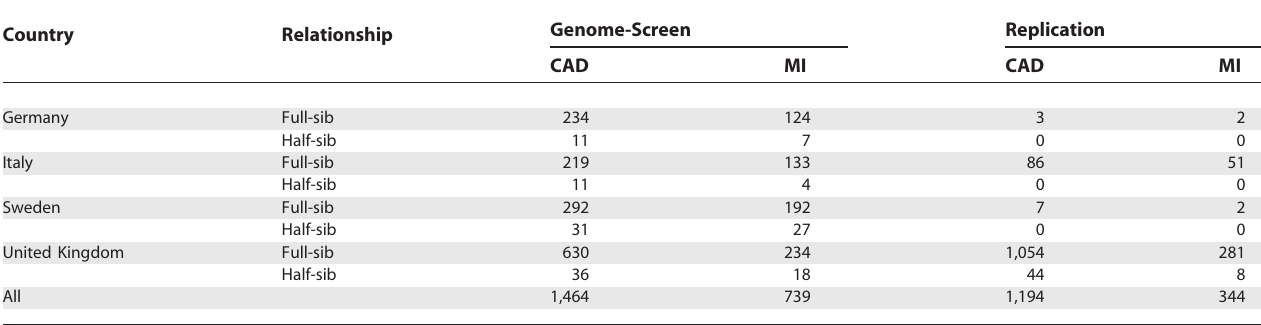
Table 1. Country of Residence and Degree of Relatedness for Affected Sib-Pairs in the Genome-Screen and Replication Cohorts